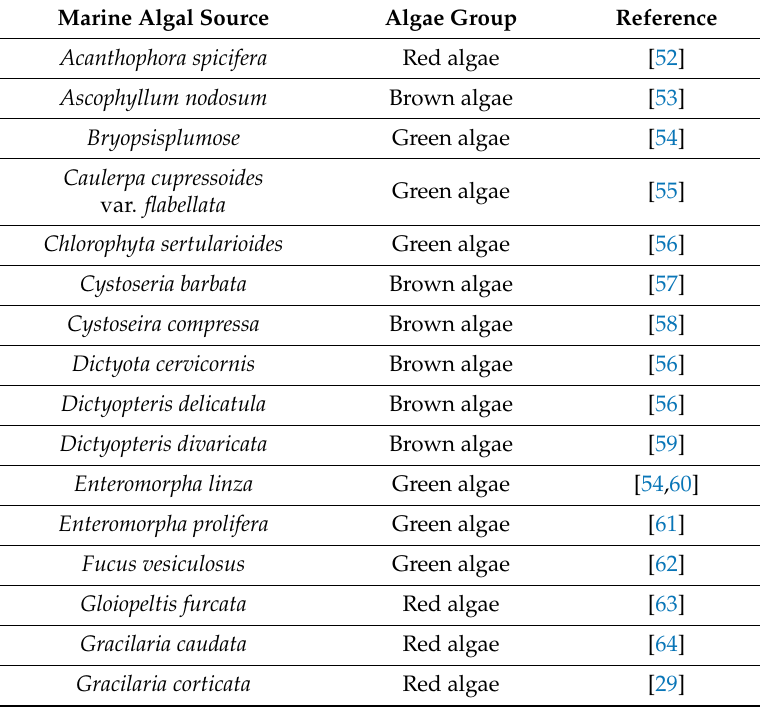
Figure 1. Sulfated polysaccharide chemical structures of ( A ) Fucoidan, ( B ) Carrageenan, ( C ) Porphyran, ( D ) Ulvan. Table 6. Marine algae source with antioxidant activity attributed to SPs.